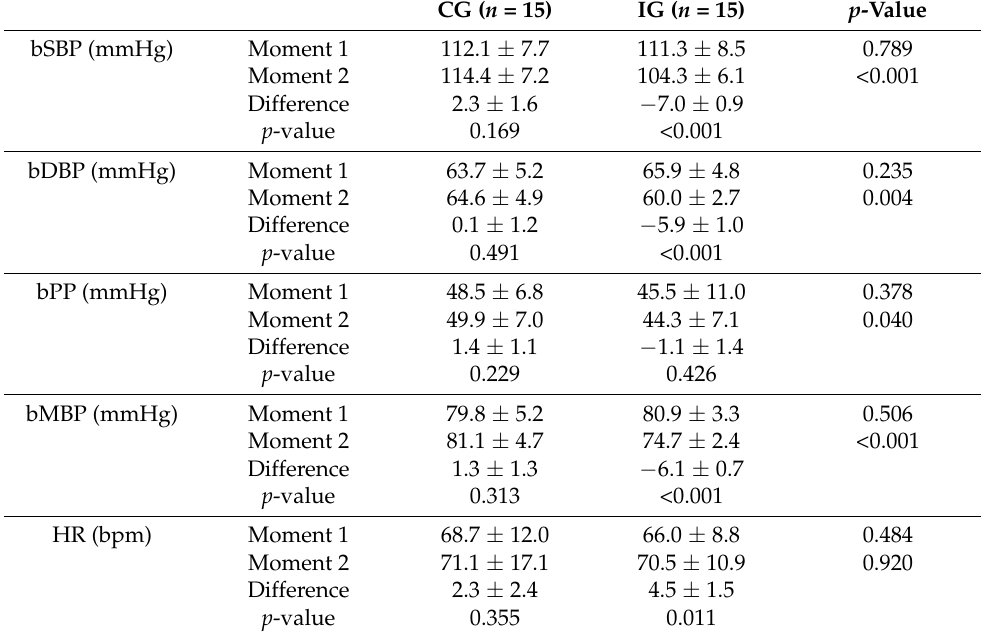
Table 3. Mean values of blood pressure and heart rate at moment 1 (baseline) and moment 2 (post-intervention) in both groups, showing the evolution between the 2 moments. CG ( n = 15) IG ( n = 15) p -Value bSBP (mmHg) Moment 1 112.1 ±